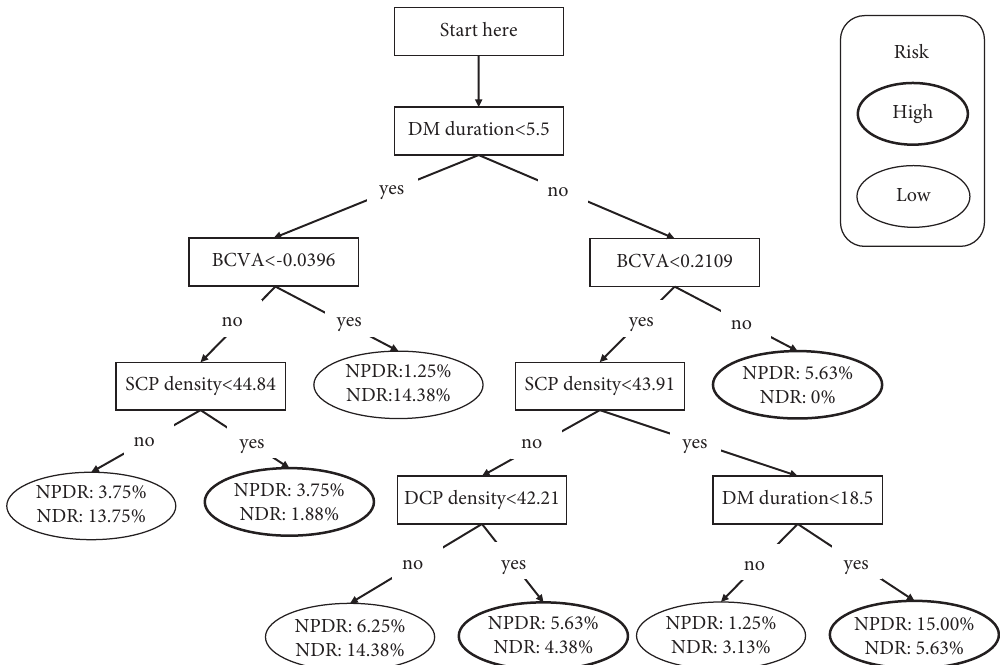
Figure 3: Classification tree for detecting non-proliferative diabetic retinopathy. DM, diabetes mellitus; BCVA, best-corrected visual acuity; SCP, superficial capillary plexus; DCP, deep capillary plexus; NPDR, nonproliferative diabetic retinopathy; NDR, nondiabetic retinopathy.